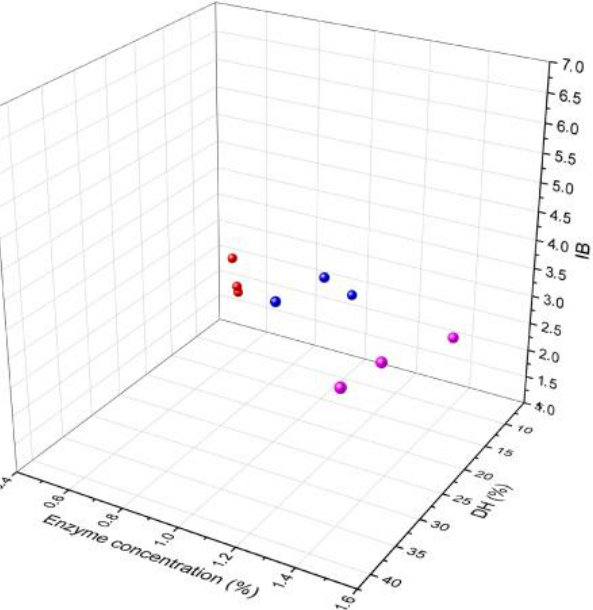
Figure 1. The influence of enzyme concentration on the IB and DH: red (0.5% enzyme concentration); blue (1% enzyme concentration); pink (1.5% enzyme concentration).